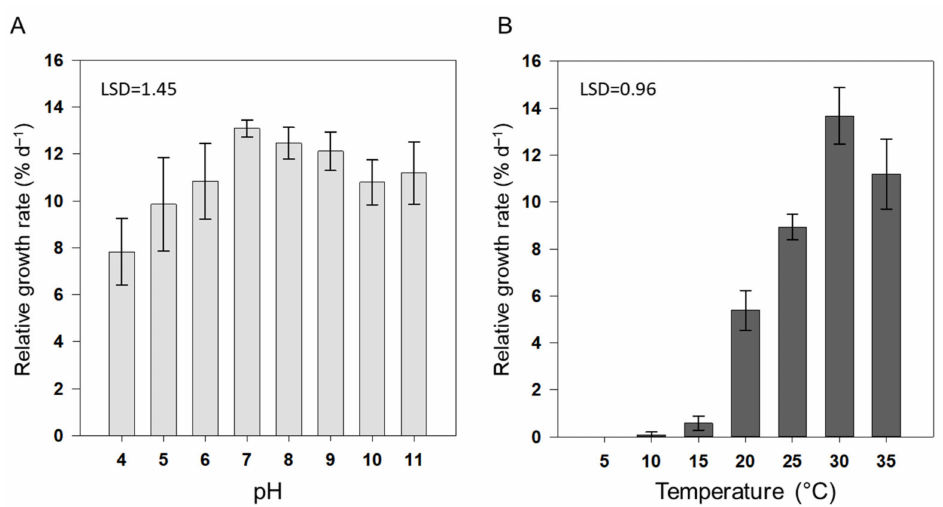
Figure 1. Effects of pH and temperature on the relative growth rate (RGR) of Arthrospira maxima cultures. Effects of various pH values ( A ) and temperatures ( B ) on RGRs. Data represent mean ± stan- dard deviation (SD; n =